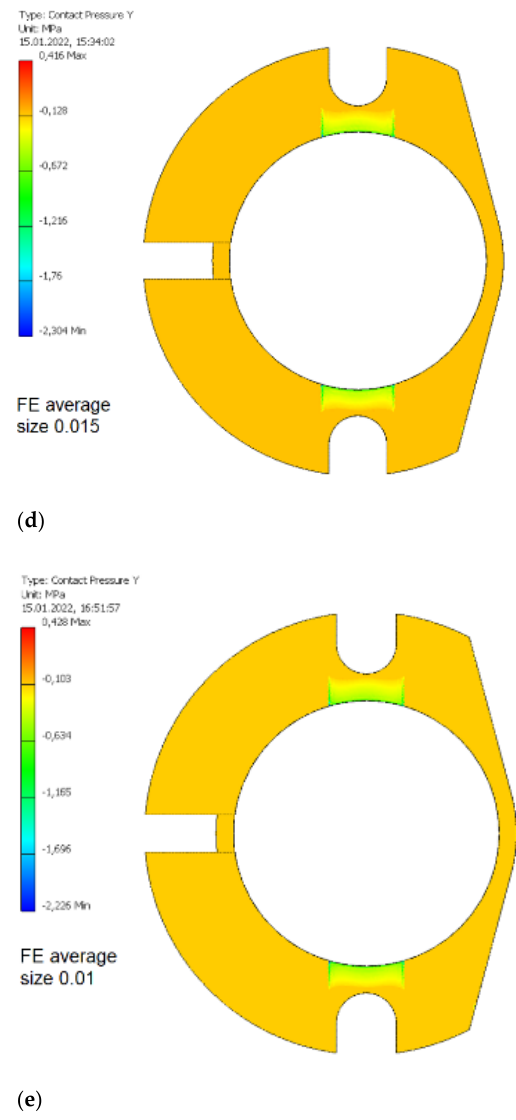
Figure 9. The values of normal contact pressure in the contact zone between the swivel arm and the bobbin case for the various average finite element relative sizes. ( a ) 0.1; ( b ) 0.05; ( c ) 0.02; ( d ) 0.015; ( e ) 0.01. Table 9. The maximum values of normal contact pressure in the contact zone between the swivel arm and the bobbin case for various average finite element sizes.